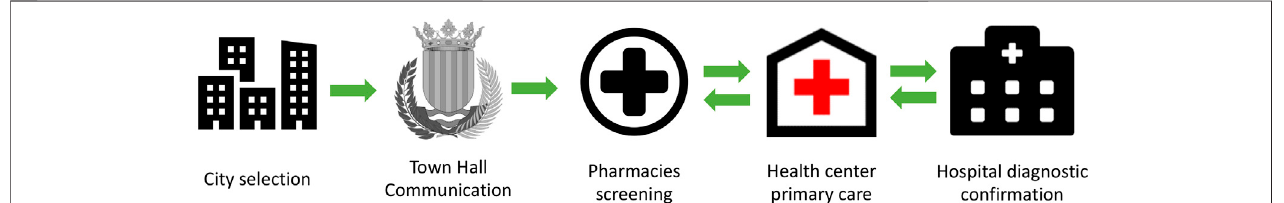
FIGURE 1 | Route to improve interprofessional collaboration into clinical practice to promote IPC group.